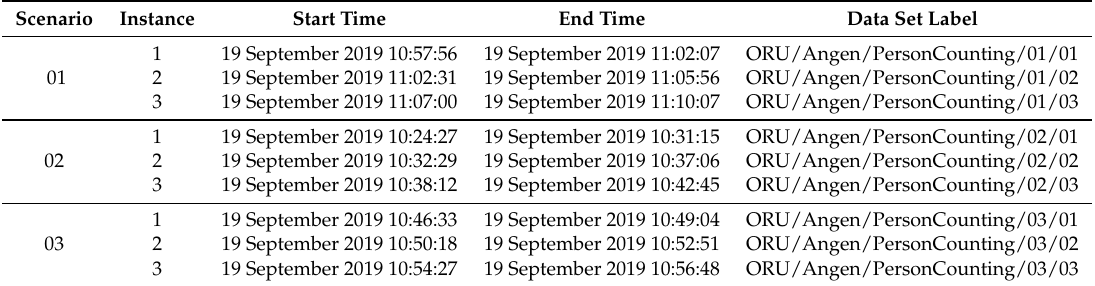
Table 6. Start and end times for the different instances of the three